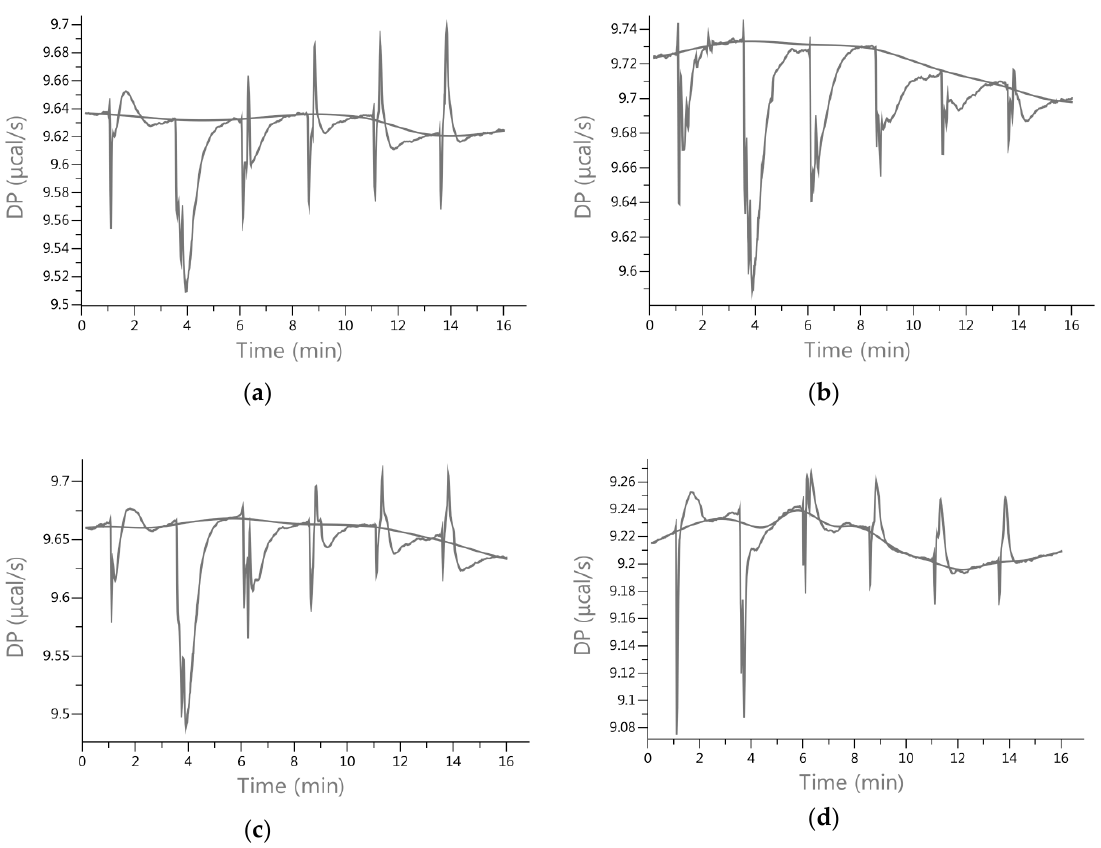
Figure 2. ITC raw data from the titration of actin with red clover sprout extracts cultivated under ( a ) white light for 10 days; ( b ) UVA 3 for days; ( c ) UVA for 8 days; ( d ) UVB for 11 days.